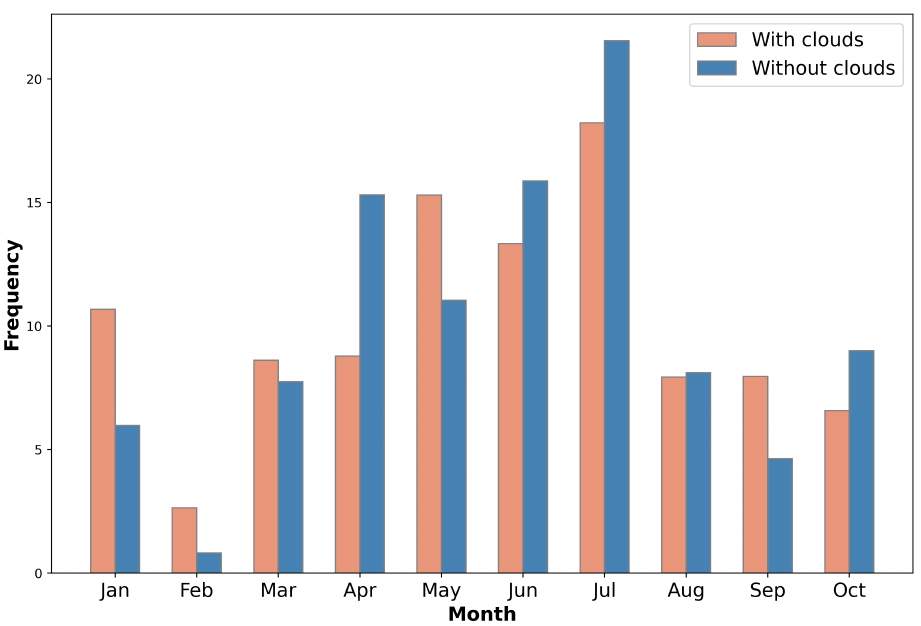
Figure 13. Feature importance of each month with and without clouds.